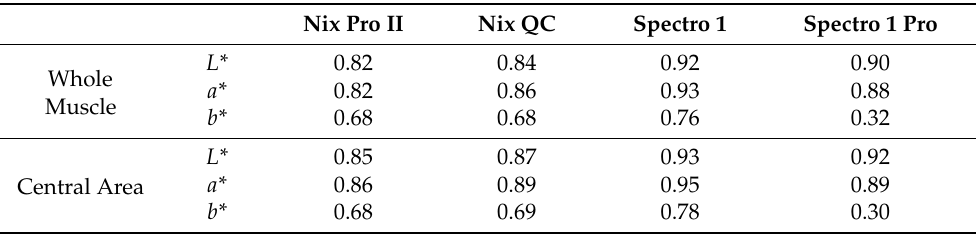
Table 4. Correlations between meat colour measurements from Minolta and novel instruments. Nix Pro